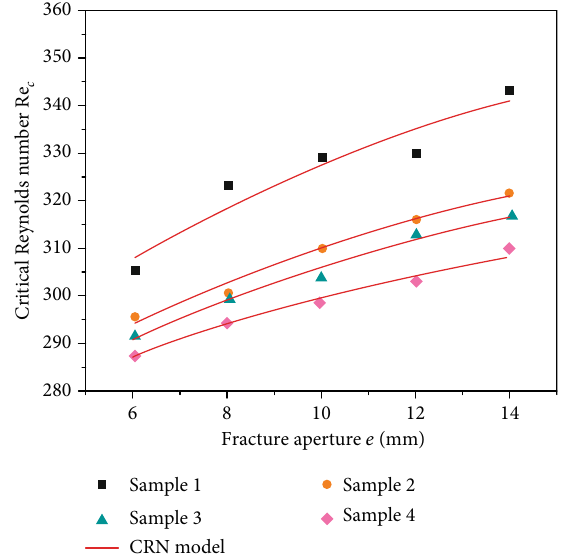
Figure 15: Variation of critical Reynolds number with the fracture